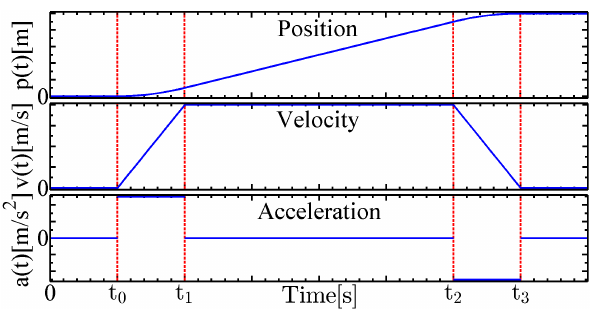
Figure 18: Optimal curve